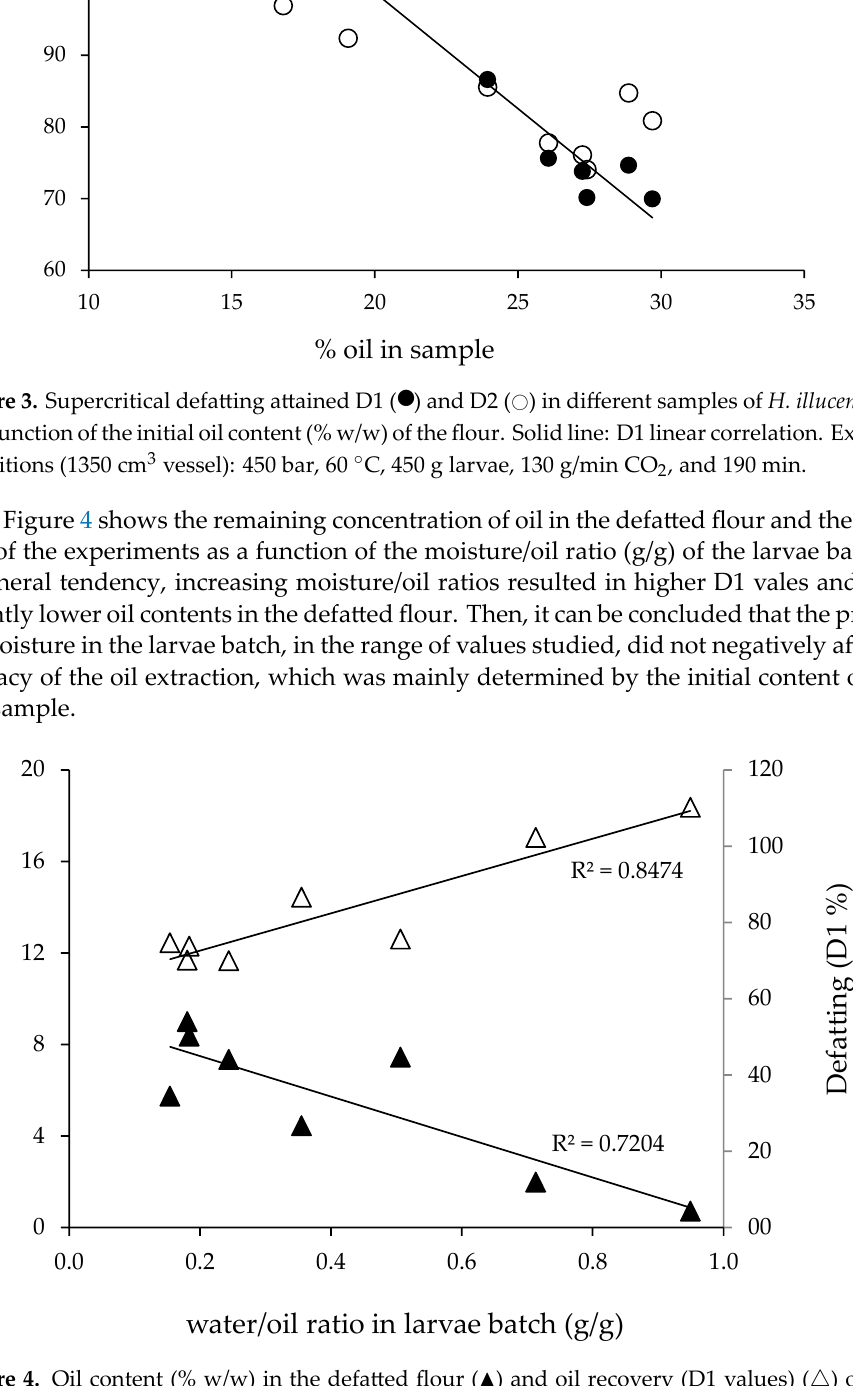
Figure 4. Oil content (% w/w) in the defatted flour ( ▲ ) and oil recovery (D1 values) ( △ ) obtained from the different H. illucens larvae batches as a function of their moisture/oil ratio. Extraction conditions (1350 cm 3 vessel): 450 bar, 60 °C, 450 g larvae, 130 g/min CO 2 , and 190 min. Solid lines: linear regressions.